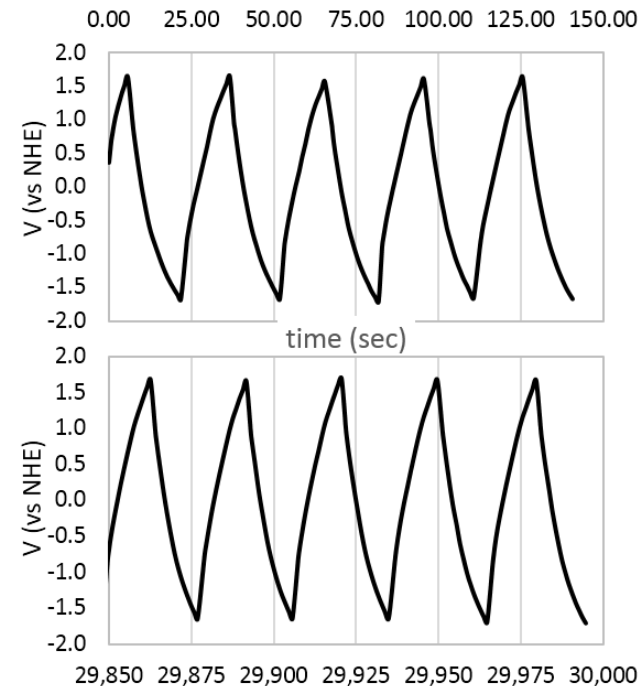
Figure 18. Galvanostatic charge–discharge curves of a + 2Ru2 functionalized HiPco SWCNT film loaded onto a carbon fiber paper current collector run for 1000 cycles. Three electrode method in 100 mM TBATFB in propylene carbonate electrolyte. Discharge current set at 8.5 A / g. First five cycles in the top graph and the last five cycles in the bottom graph.